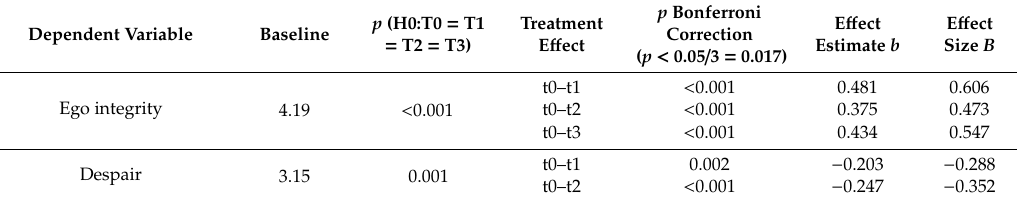
Table 8. Ego-integrity (NEIS). 1,